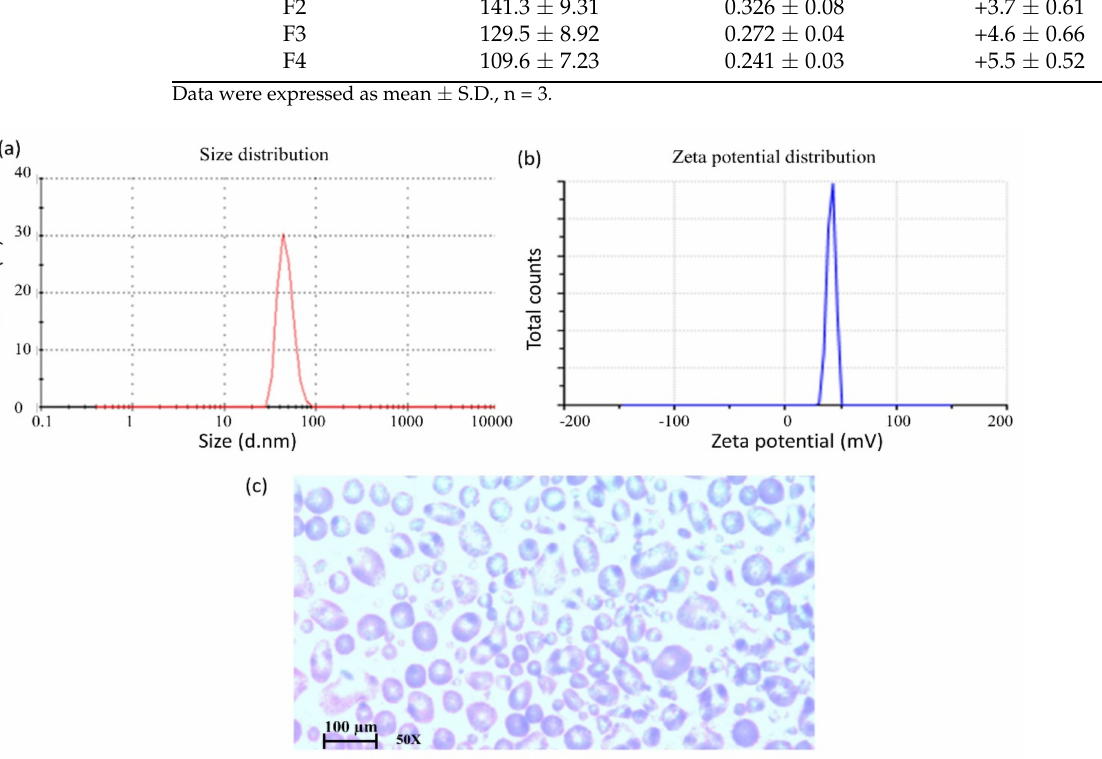
Figure 1. Representing the size ( a ) and zeta potential ( b ) of the emulsions and ( c ) A microscopic image of the emulsions containing 5-FU was captured using a light microscope (CX41RF, OLYMPUS), 50 × magnification. Data were expressed as n =